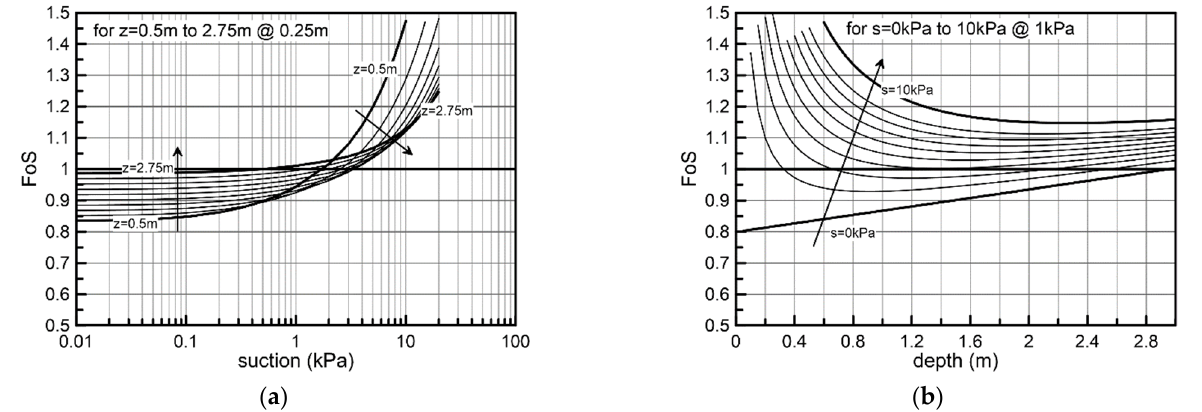
Figure 8. ( a ) Evolution of FoS with suction for different slope heights; ( b ) evolution of FoS with slope height for different suction levels; results from a 3D mechanism (with lateral resistance).